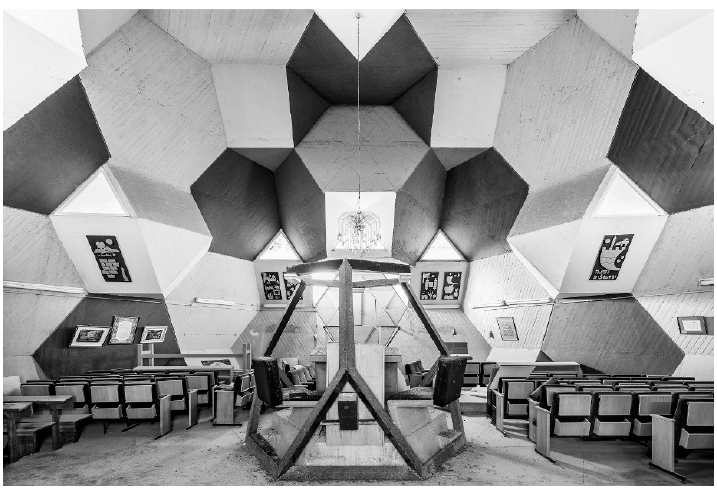
Figure 7. The Military Officers’ Academy Synagogue in Mitzpe Ramon. Interior view facing the bimah and the Torah Ark. Eli Singalovsky, Bahad 1 #1 , 2018. Archival pigment print, 100 cm × 67 cm. Used with